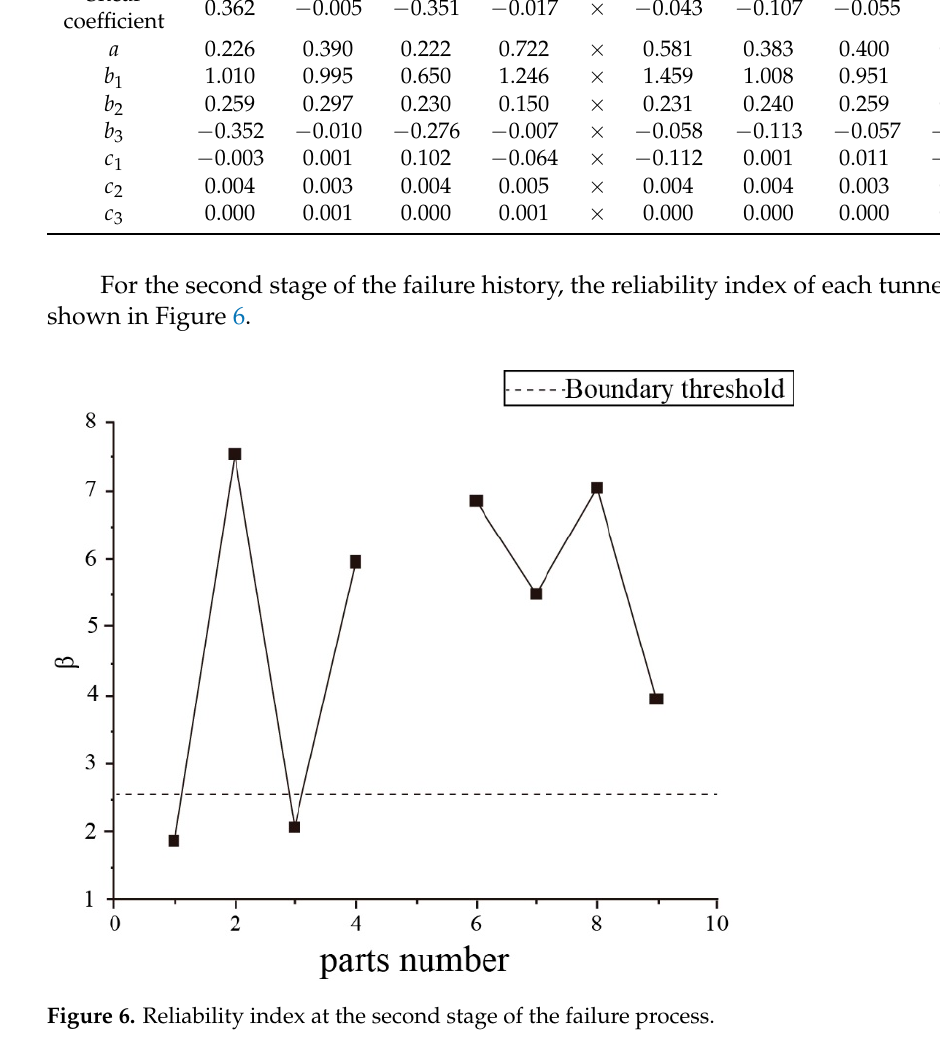
major failure parts. After the partial failure of the structure, the reliability of some parts may increase. This is because the stress redistribution will occur after the local failure of the structure, which may result in the stress of some parts being less than the previous state. At the third stage of the failure process, the failure path exhibits two branches. The reliability index of the different failure paths at the third stage is shown in Figure 7a,b. At the fourth stage of the failure process, the reliability indices of all of the tunnel parts are larger than three, and the failure process is terminated. The failure tree consisting of the main failure paths and the corresponding reliability indices are shown in Figure 8. The upper part of the box is the failure part of the structure, and the lower part is the reliability index of the failure part. Similarly, the failure tree and corresponding reliability indices when λ = 1 and λ = 2 are shown in Figures 9 and 10,